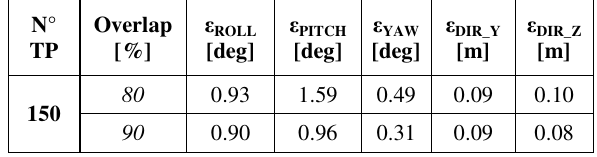
Table 9. Error propagated – 150 TP – simulation 3